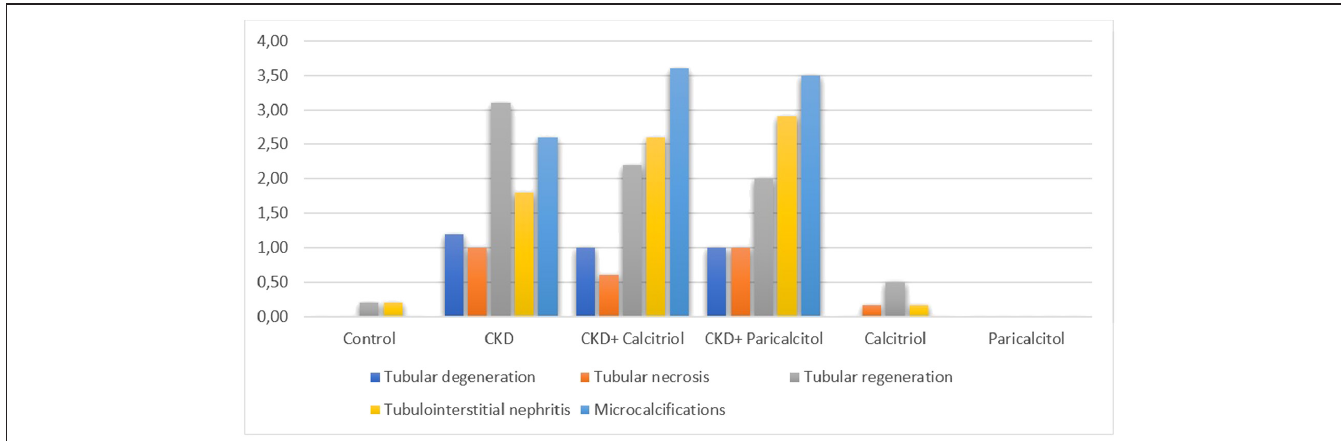
Figure 3. Comparison of histopathological data between